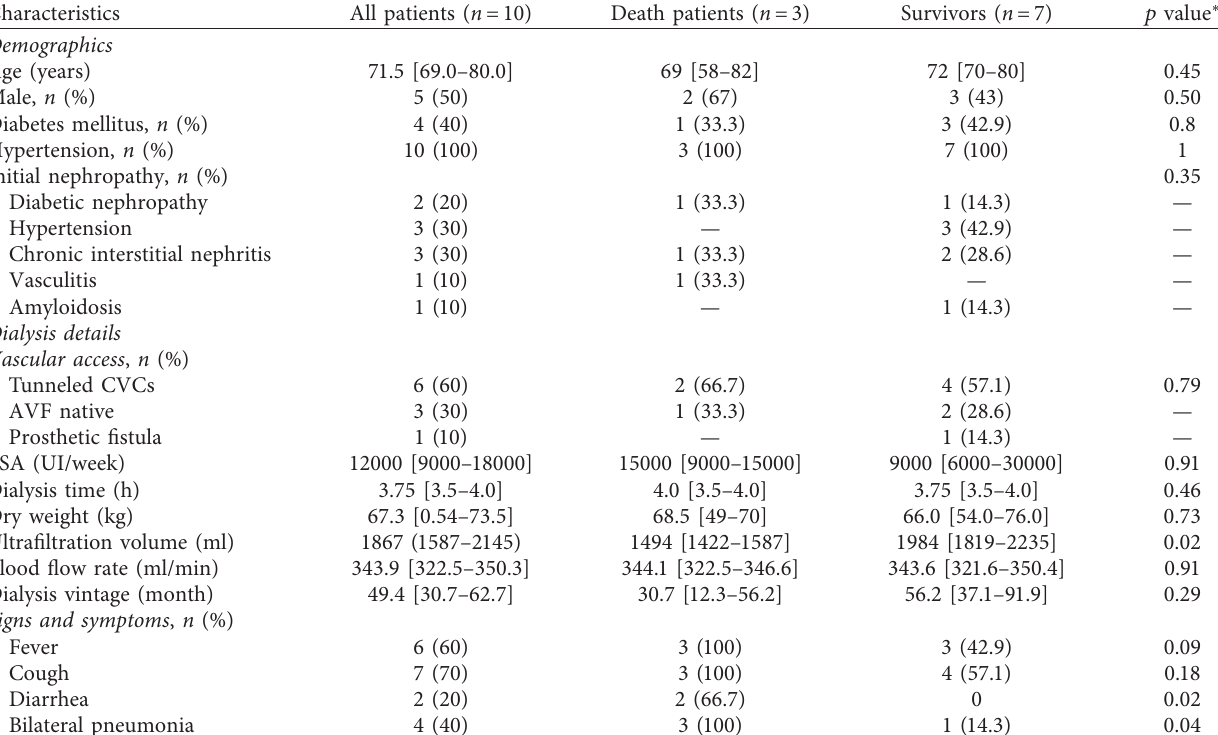
Table 1: Patients characteristics, dialysis parameters, and clinical findings at COVID-19 diagnosis.